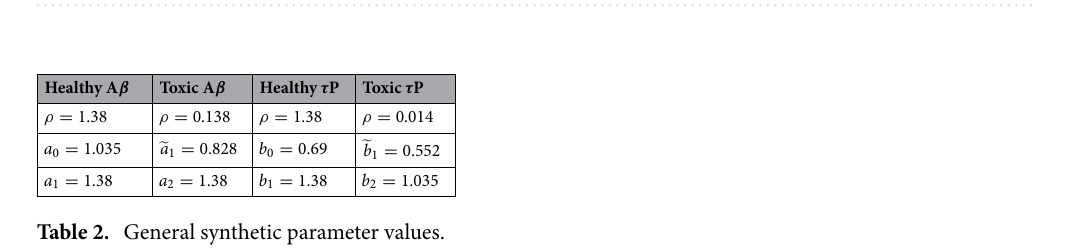
Figure 6. (Color online) Spatial average of the damage of all the nodes with respect to time for different values of k 4 : k 4 = 0.001 (dotted), k 4 = 0.01 (dashed-dotted) and k 4 = 0.1 (solid).